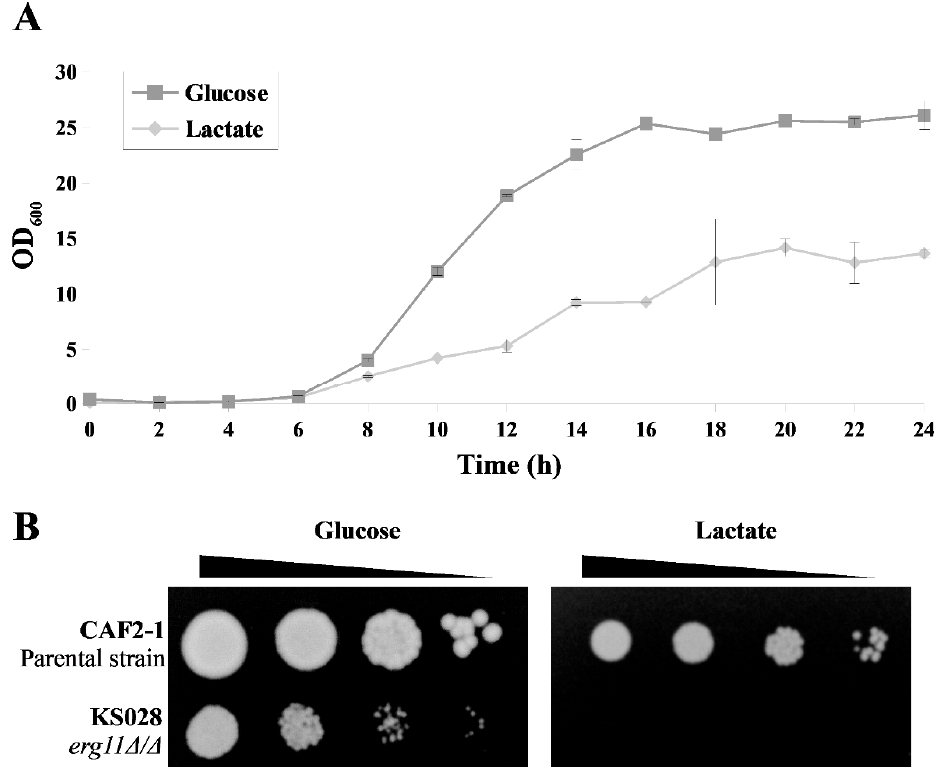
Figure 4. ( A ) Growth curves of C. albicans CAF2-1 strains in YPD (glucose) or YPL (lactate) medium (28 °C, 120 rpm), represented as OD 600 (means ± SD, n = 4). ( B ) Growth phenotypes of C. albicans CAF2-1 (parental strain) and KS028 ( erg11 Δ / Δ ) strains after 48 h incubation at 28 °C in YPD or YPL medium.